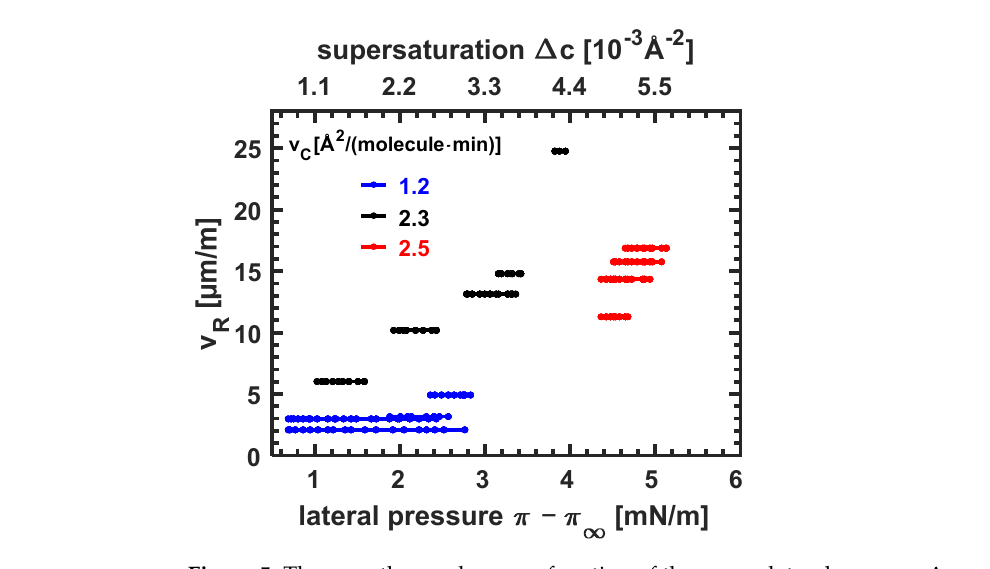
Figure 5. The growth speed v R as a function of the excess lateral pressure ∆ π = π − π ∞ for three monolayers compressed with three different compression velocity v C as indicated. Additionally, shown is the supersaturation Δ𝑐 in the LE phase. The data were derived from Figure 4.